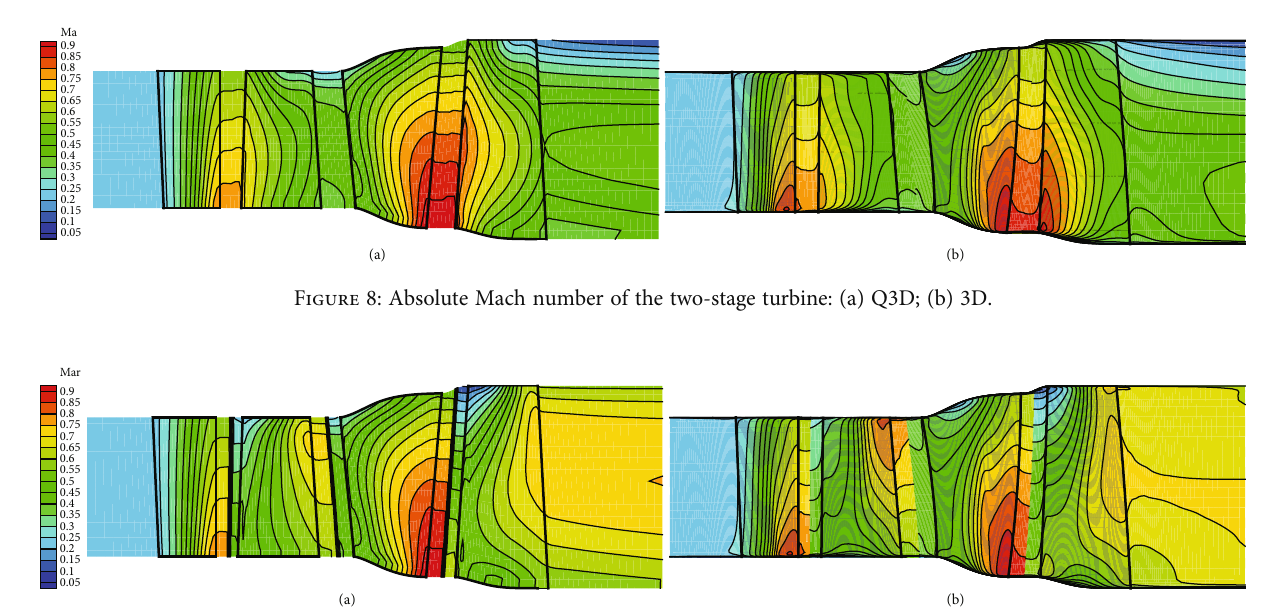
Figure 9: Relative Mach number of the two-stage turbine: (a) Q3D; (b) 3D.